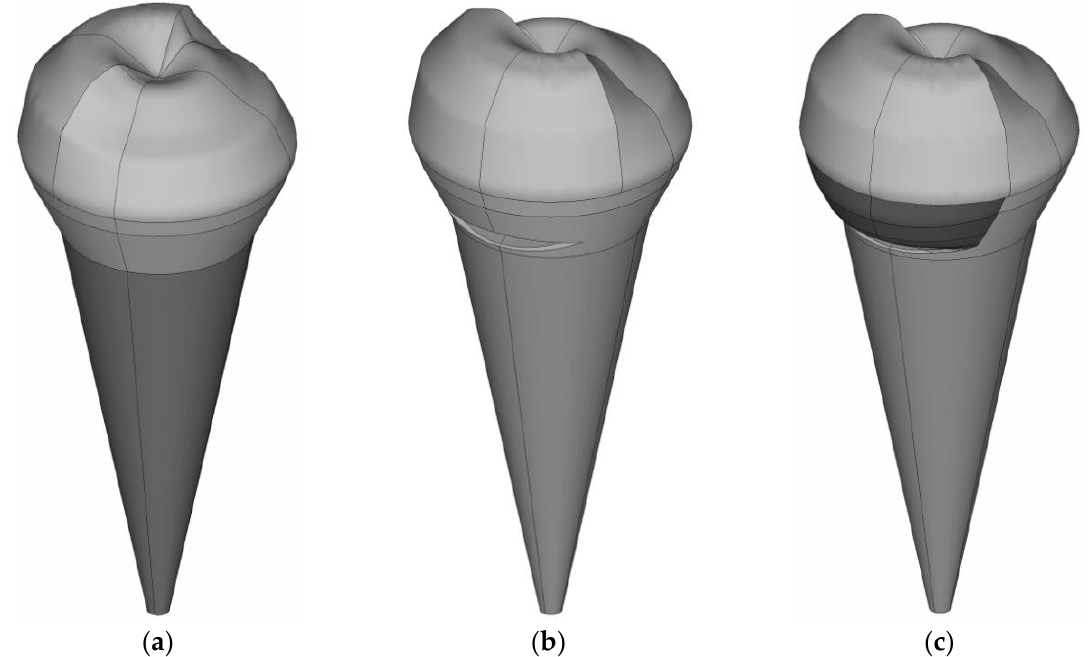
Figure 12. Models of teeth taking into account the root system simple geometry: ( a ) is without defect; ( b ) is with a defect; ( c ) is with the restoration new type.